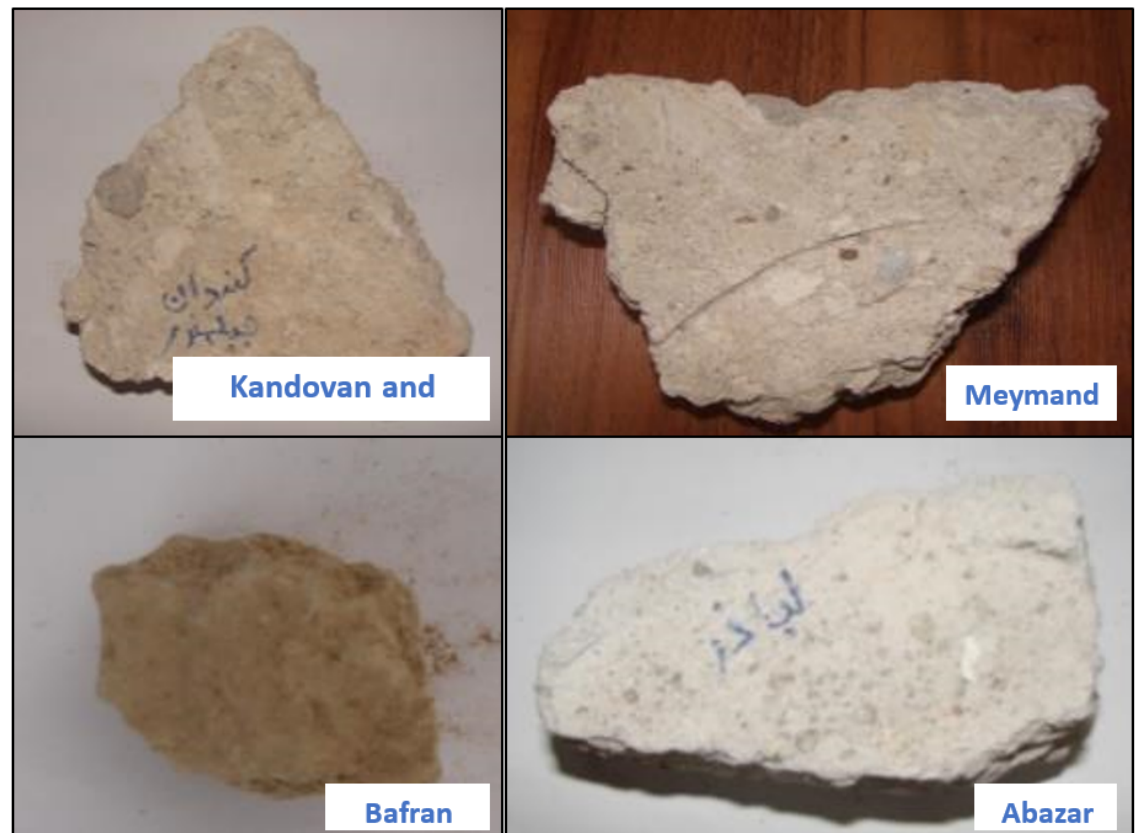
Figure 8. Pumice stones found in Meymand, Kandovan and Abazar and their difference with the dense sediment found in Bafran.